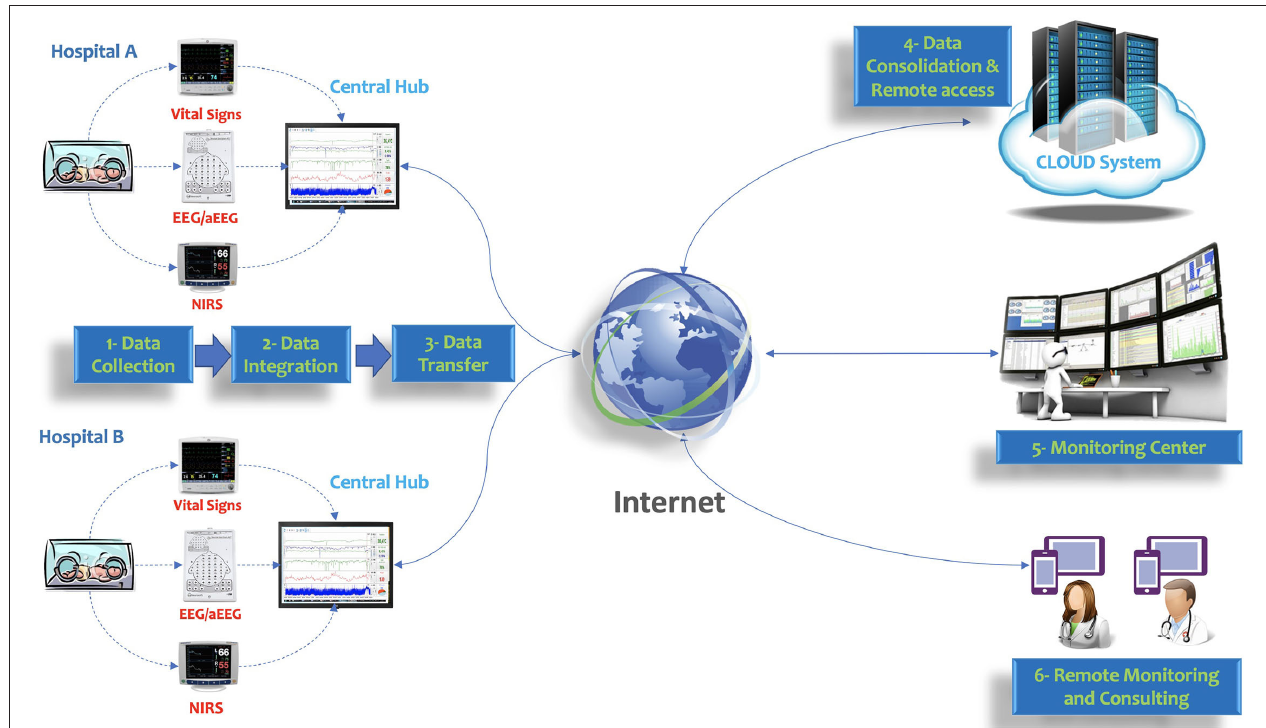
FIGURE 5 | Model of architecture for multimodal monitoring accessed by telemedicine approach. Vital signs, EEG/aEEG, and NIRS are integrated using a central hub. The encrypted data is transferred to the cloud system and accessed by a monitoring center or remote